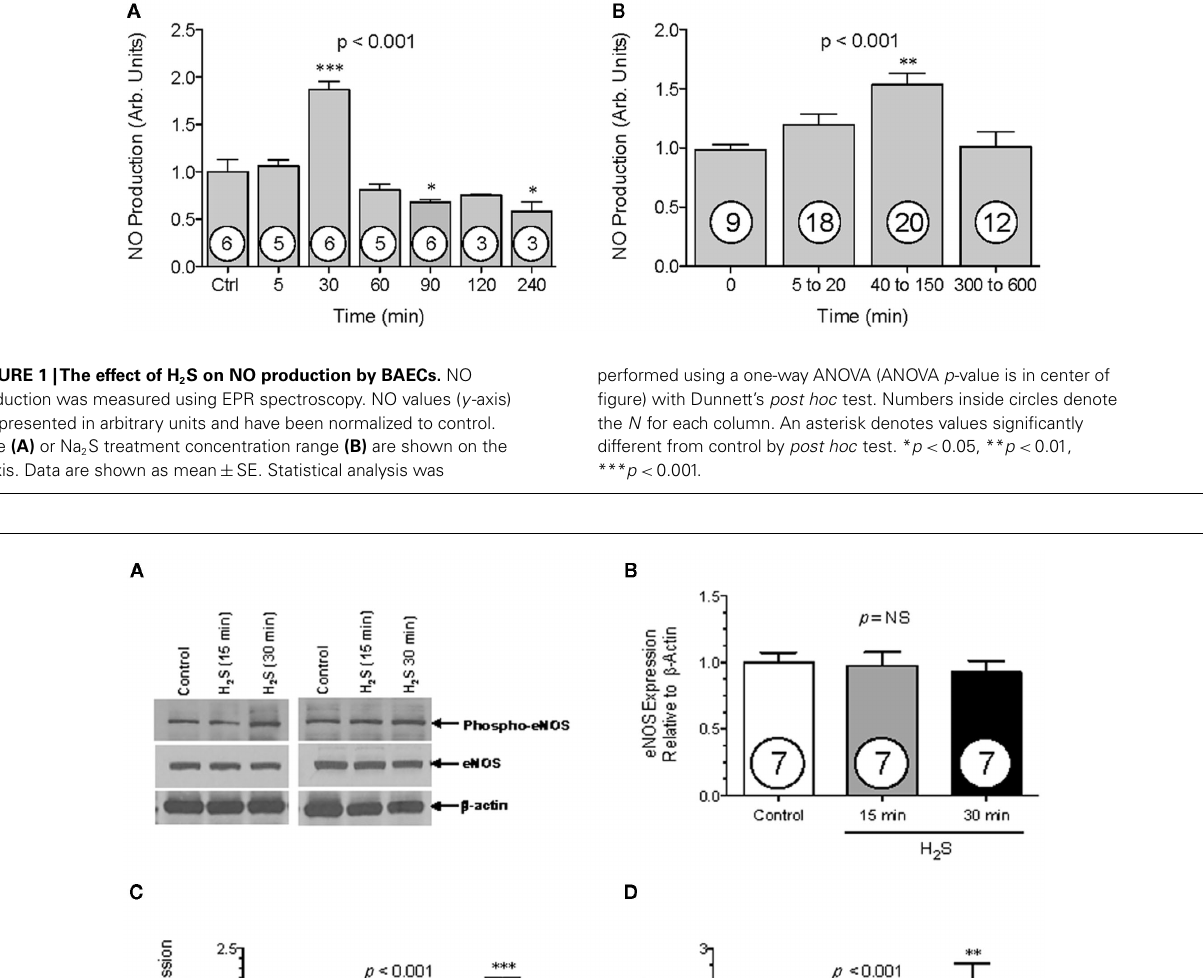
FIGURE 2 |The effect of H 2 S on eNOS phosphorylation. Protein expression ( y -axis, normalized to β -actin) was measured from BAECs untreated (Ctrl), or exposed to 15 or 30min of 150 μ M Na 2 S ( x -axis). Densiometric analysis values have been normalized to control. (A) RepresentativeWestern blots. (B) Total eNOS expression (C) eNOS phosphorylated at Ser 1177 expression. (D) The ratio eNOS